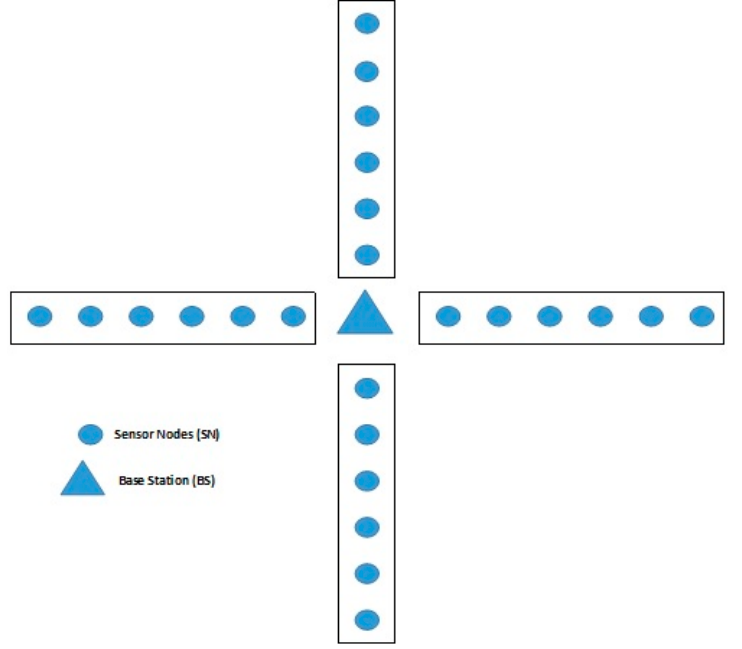
Figure 2. Multiple straight pipelines.